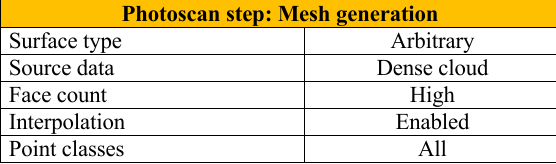
Table 7. Mesh generation settings for all